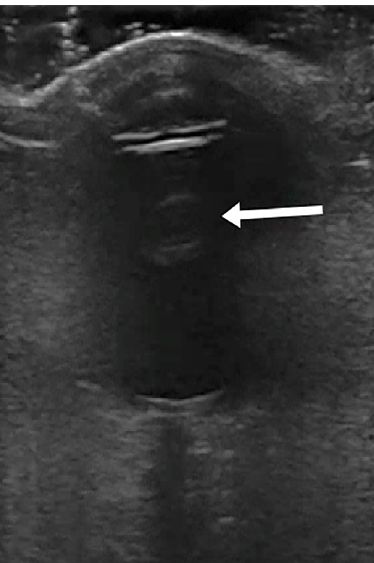
Image 2. Hyperechoic spherical structure seen in the posterior chamber of the left eye noted at the tip of the